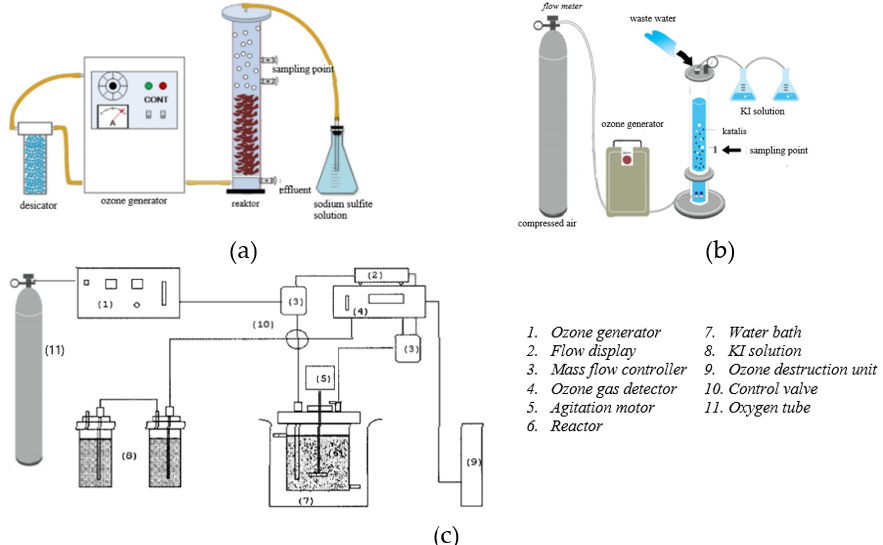
Figure 17. Catalytic ozonation reactor apparatus ( a ) Batch reactor; ( b ) semi-batch reactor; and ( c ) semi-batch stirred reactor. Reproduced from Refs. [105,106,109]. Copyright 2017 and 2018 Elsevier.